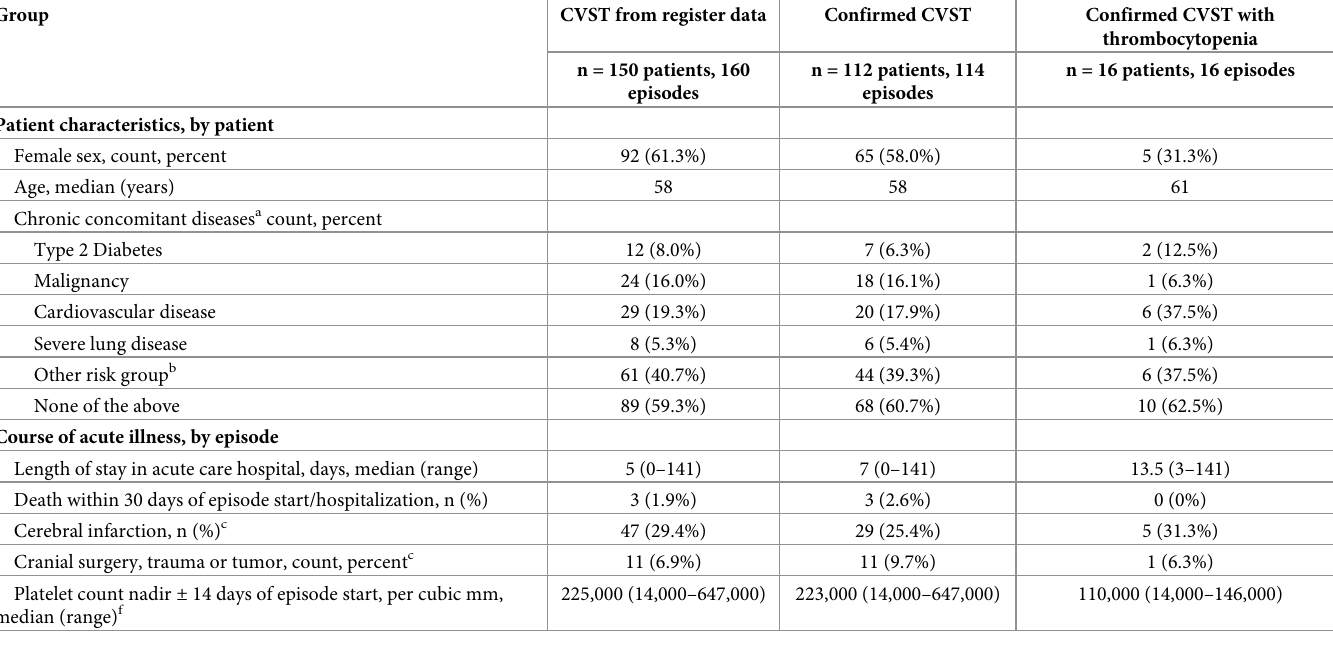
Table 2. Characteristics and course of illness concerning patients and episodes of cerebral venous sinus thrombosis in unvaccinated subjects.